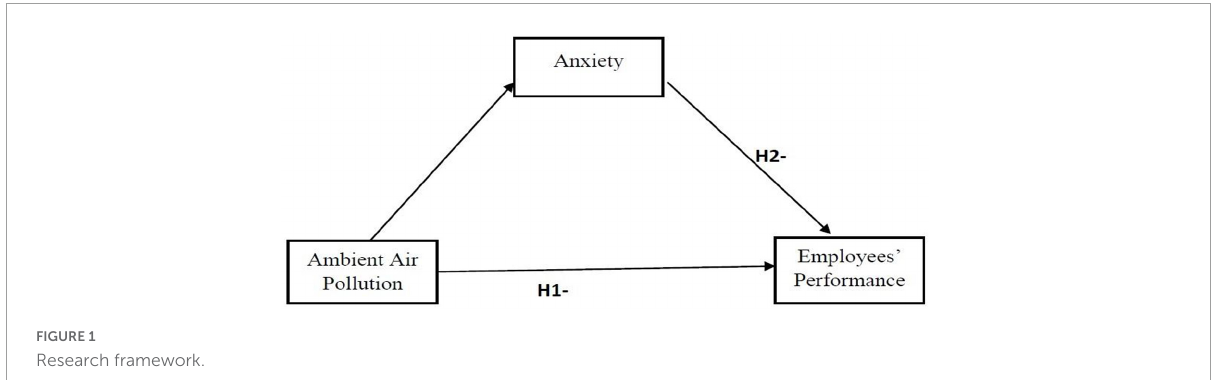
FIGURE1 Research framework.